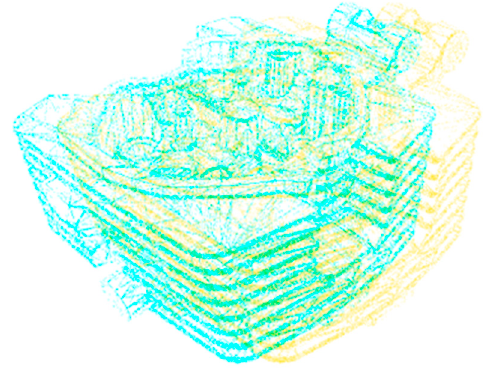
Figure 15. Comparing the matching graph.